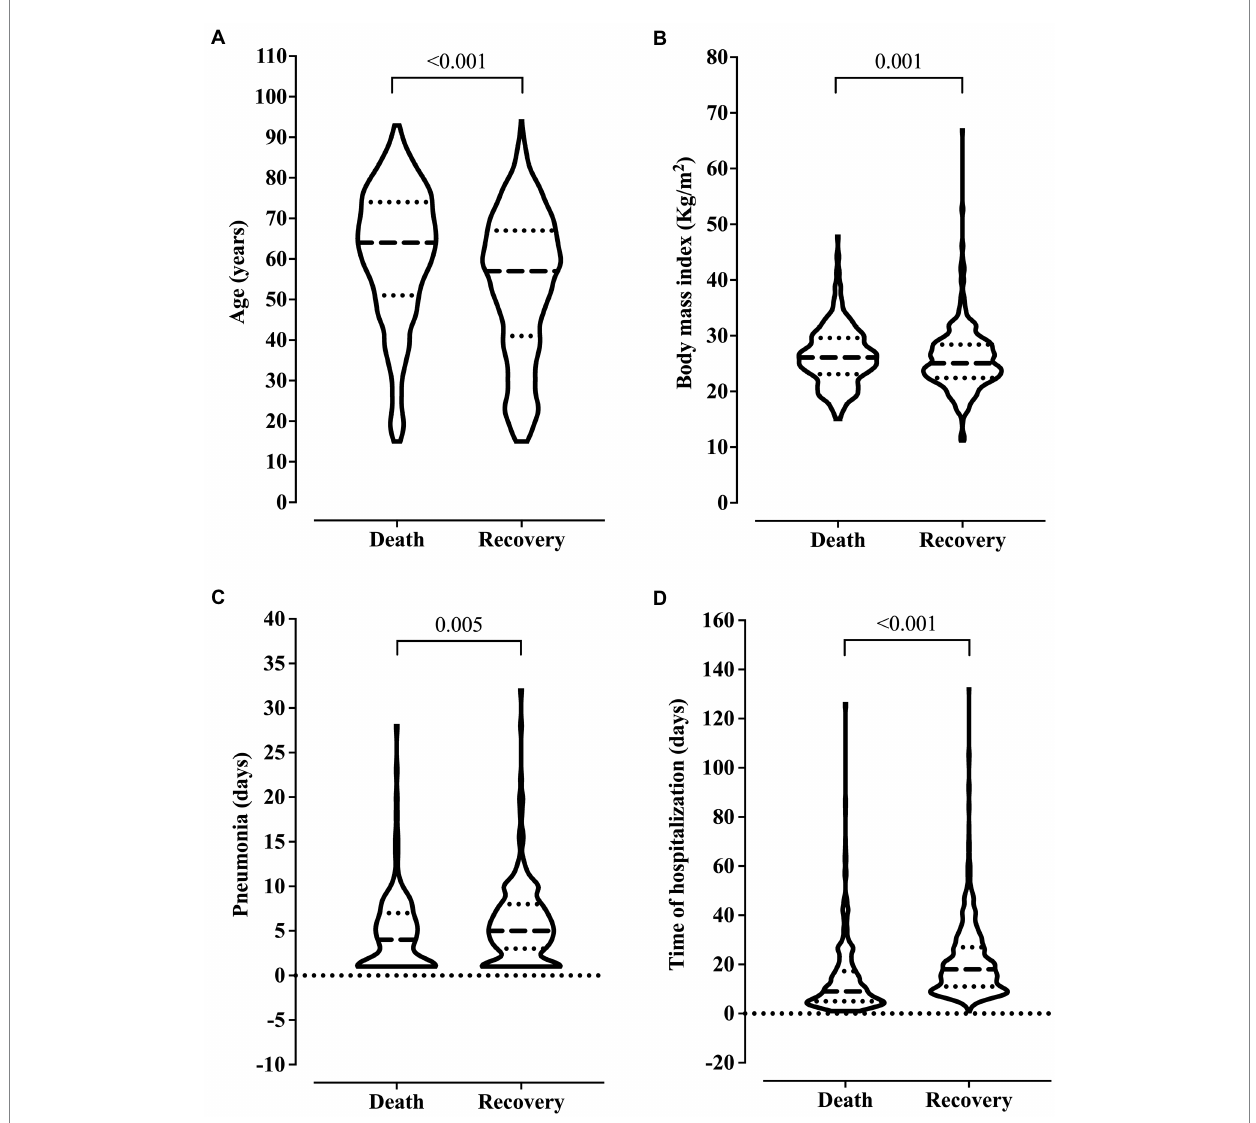
FIGURE 2 Association between clinical outcome and age (A) , body mass index (B) , ventilation-associated pneumonia (C) , and length of hospital stay (D) . We carried out the statistical analysis using the Mann–Whitney test and a 0.05 alpha